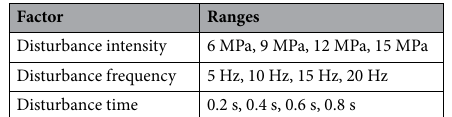
Table 2. Numerical simulation test factors and value ranges.